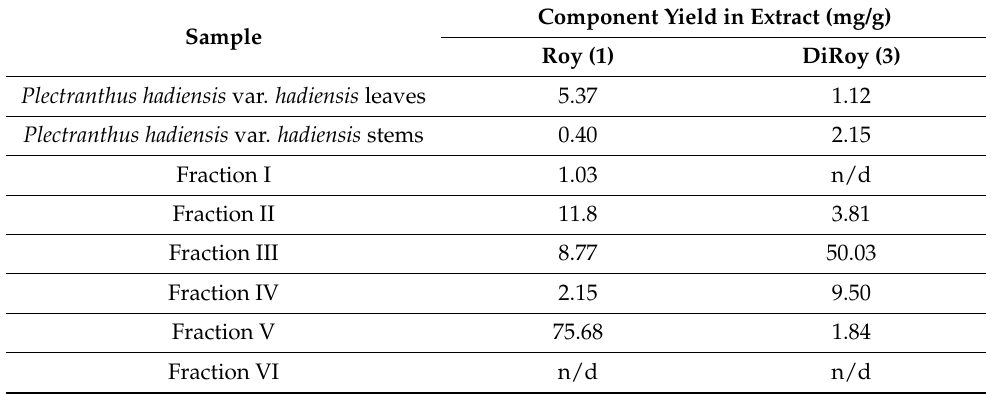
Table 2. Component quantification of P. hadiensis